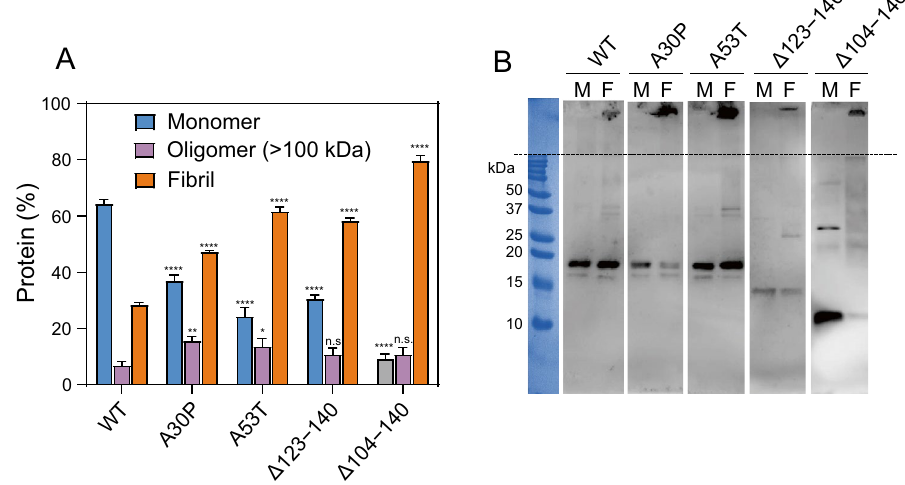
Figure 3. Determination of α-syn species at plateau phase of fibril formation. ( A ) Quantitative analysis of relative amounts of monomeric, oligomeric, and fibrillar forms of α-syn at plateau phase. Solution of 20 μM monomeric α-syn was incubated at 37 °C for 3 days with shaking. After the incubation, amyloid fibrils were precipitated by ultracentrifugation, and the resultant supernatant was filtrated using 100-kDa cut-off filter to separate monomeric and oligomeric forms of α-syn. Amounts of proteins in each fraction were determined by the Lowry method. Error bars represent S.E. * p < 0.05; ** p < 0.01; **** p < 0.0001 versus each form of WT. n.s., not significant. ( B ) Western blot analysis of α-syn solution after the incubation at 37 °C for 3 days. Solution of α-syn before (M, monomeric) and after (F, fibrillar) the incubation was run on 15% SDS-PAGE gels, transferred to PVDF membrane, and detected using anti-α-syn polyclonal antibody for WT, A30P, A53T, and Δ123–140 or anti-α-syn N103 fragment polyclonal antibody for Δ104–140. The amounts of loaded protein were 250 ng/lane for WT, A30P, A53T, and Δ123–140 and 1 μg/lane for Δ104–140. The dotted line represents a border between stacking and separating